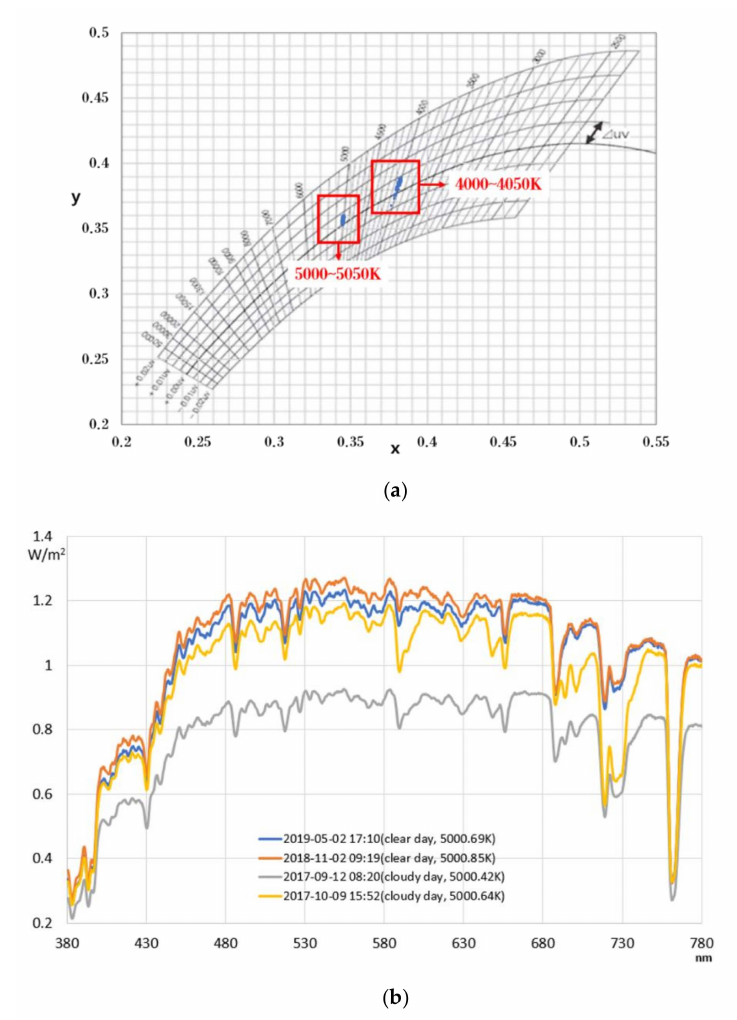
Figure 2. Characteristics of chromaticity and spectral power distribution in the same color temperature section. ( a ) xy chromaticity chart indicating the blackbody locus; ( b ) Spectral power